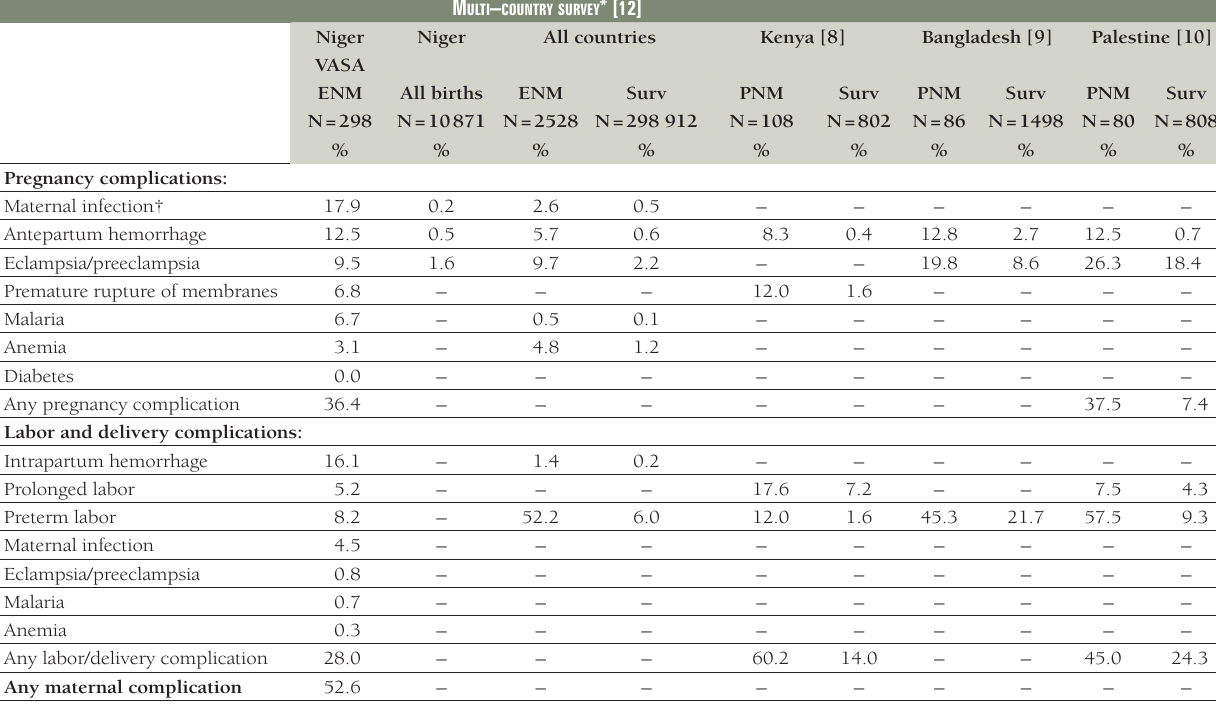
Table 3. Comparison of maternal complications among early neonatal deaths in Niger, 2007–2010, with those of all births in Niger and perinatal and early neonatal deaths and neonatal survivors in other